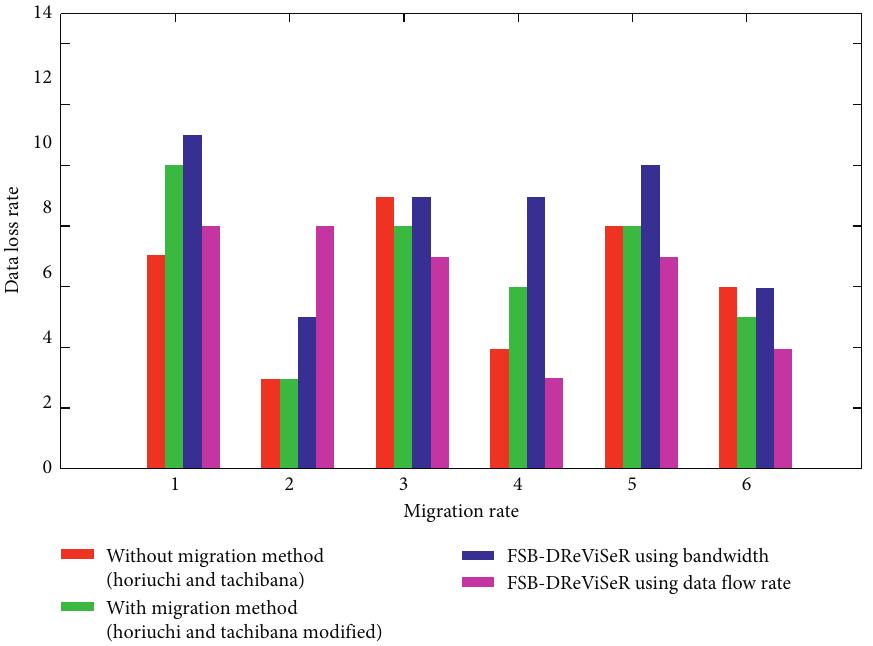
Figure 14: Data loss rate versus migration rate for a 20-node With a two-parted flow, the best replacement paths are paths 3 and 1, not paths 3 and 2 as is determined when bandwidth is used rather than the throughput.